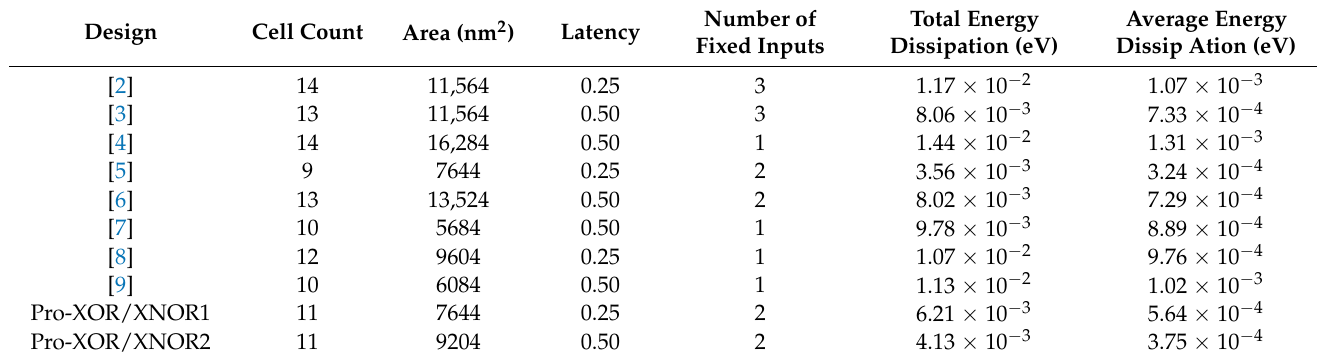
Table 3. Comparisons of the performance and energy dissipation for alternative XOR/XNOR gates.